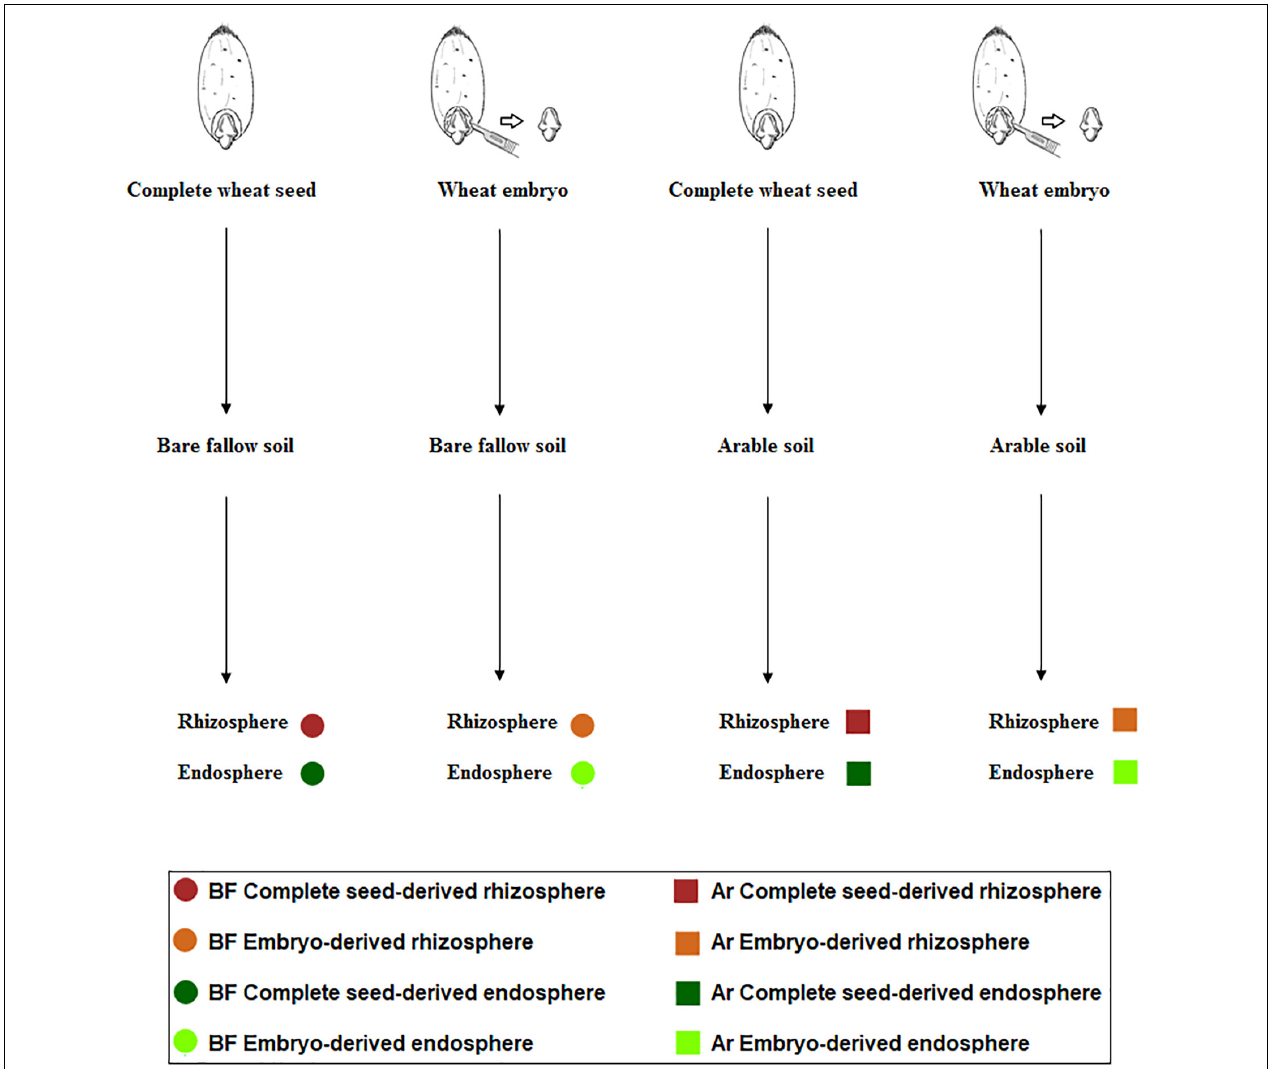
FIGURE 1 | Scheme representing the setup of the experiment to recover culturable rhizosphere (brown) and endosphere (green) bacteria from complete wheat seeds (dark color) and embryos (light color) in arable soil (square) and bare fallow soil